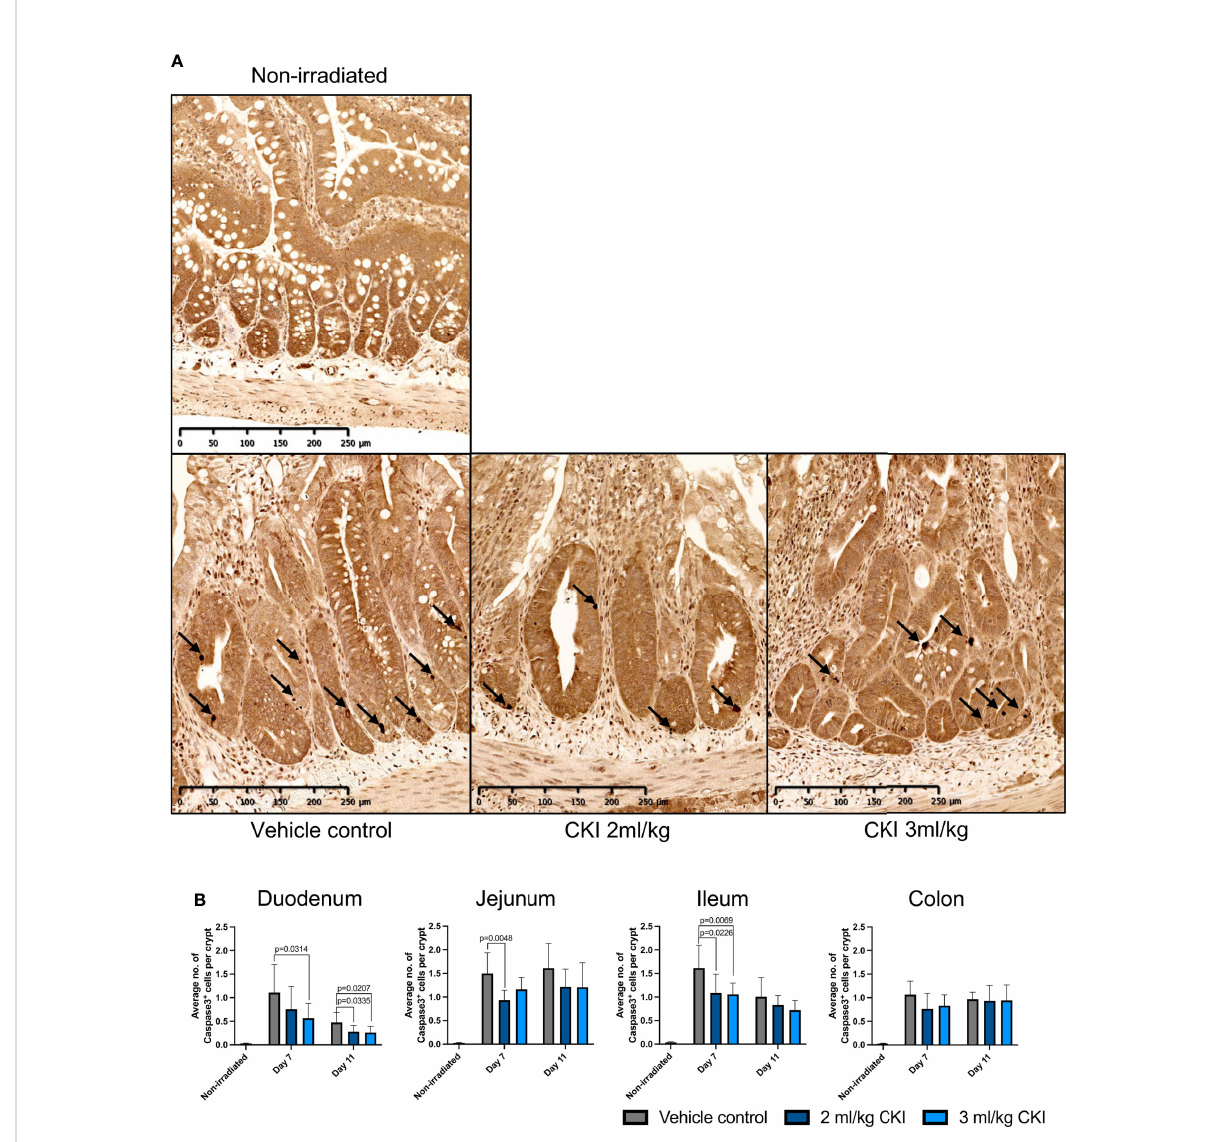
FIGURE 4 Administration of CKI prevents cell apoptosis in irradiated epithelia. (A) Representative IHC images of jejunum sections stained for Caspase-3. The jejunum sections were collected from irradiated rats on day 7 post initial irradiation and paraf fi n-embedded tissues were sectioned for IHC detection of Caspase-3. (B) Average number of Caspase-3-positive cells per crypt. The stained sections of duodenum, jejunum, ileum, and colon were analyzed and the number of Caspase-3-positive cells and crypts was counted in each fi eld of view to calculate the average number of Caspase-3-positive cells per crypt. Data are shown as mean ±